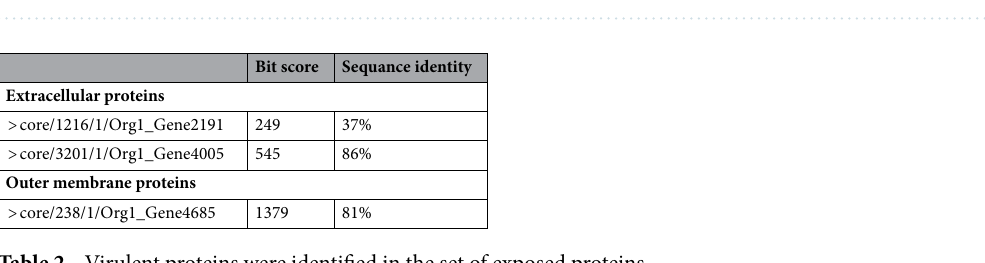
Figure 4. ( A ) Shows the percentage of the total proteome, core proteome, redundant and non-redundant proteins. ( B ) Several proteins can be found in the extracellular, periplasmic, and extracellular membranes.